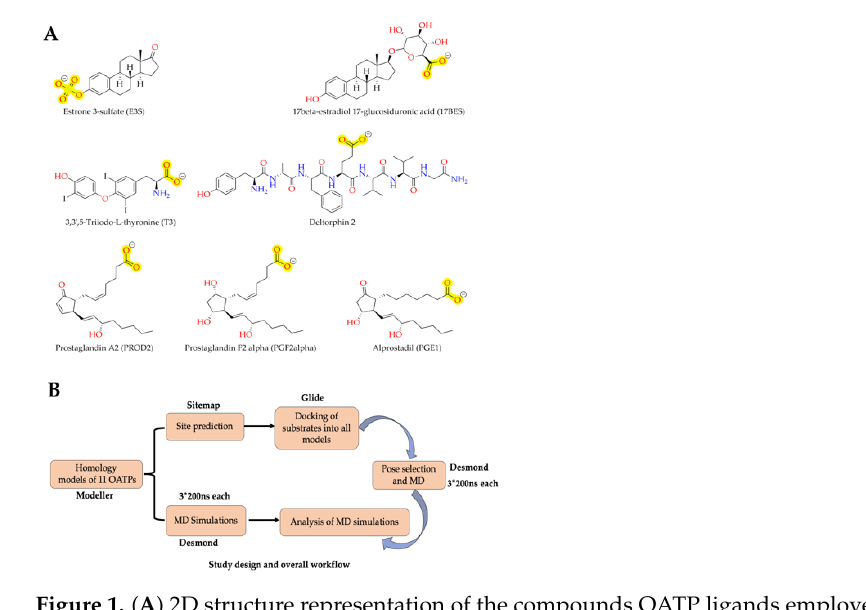
Figure 2. ( A ) OATP 2D model with transmembrane helices placed in membrane with labels. Created with BioRender.com (accessed on 8 July 2022). ( B ) A representative OATP 3D homology model with minimized in-ward open conformation. Besides this data, several studies have reported comparative models for OATPs, whose quality and information level greatly varies with the selected template [23 – 32]. For instance, Nan li et al. generated an OATP1B1 homology model based on glycerol-3-phos- phate transporter as template (PDB ID: 1PW4, from E. coli ) to interpret mutagenesis data on transmembrane helix 2 [25]. Similarly, Hong et al. generated an OATP1B1 homology